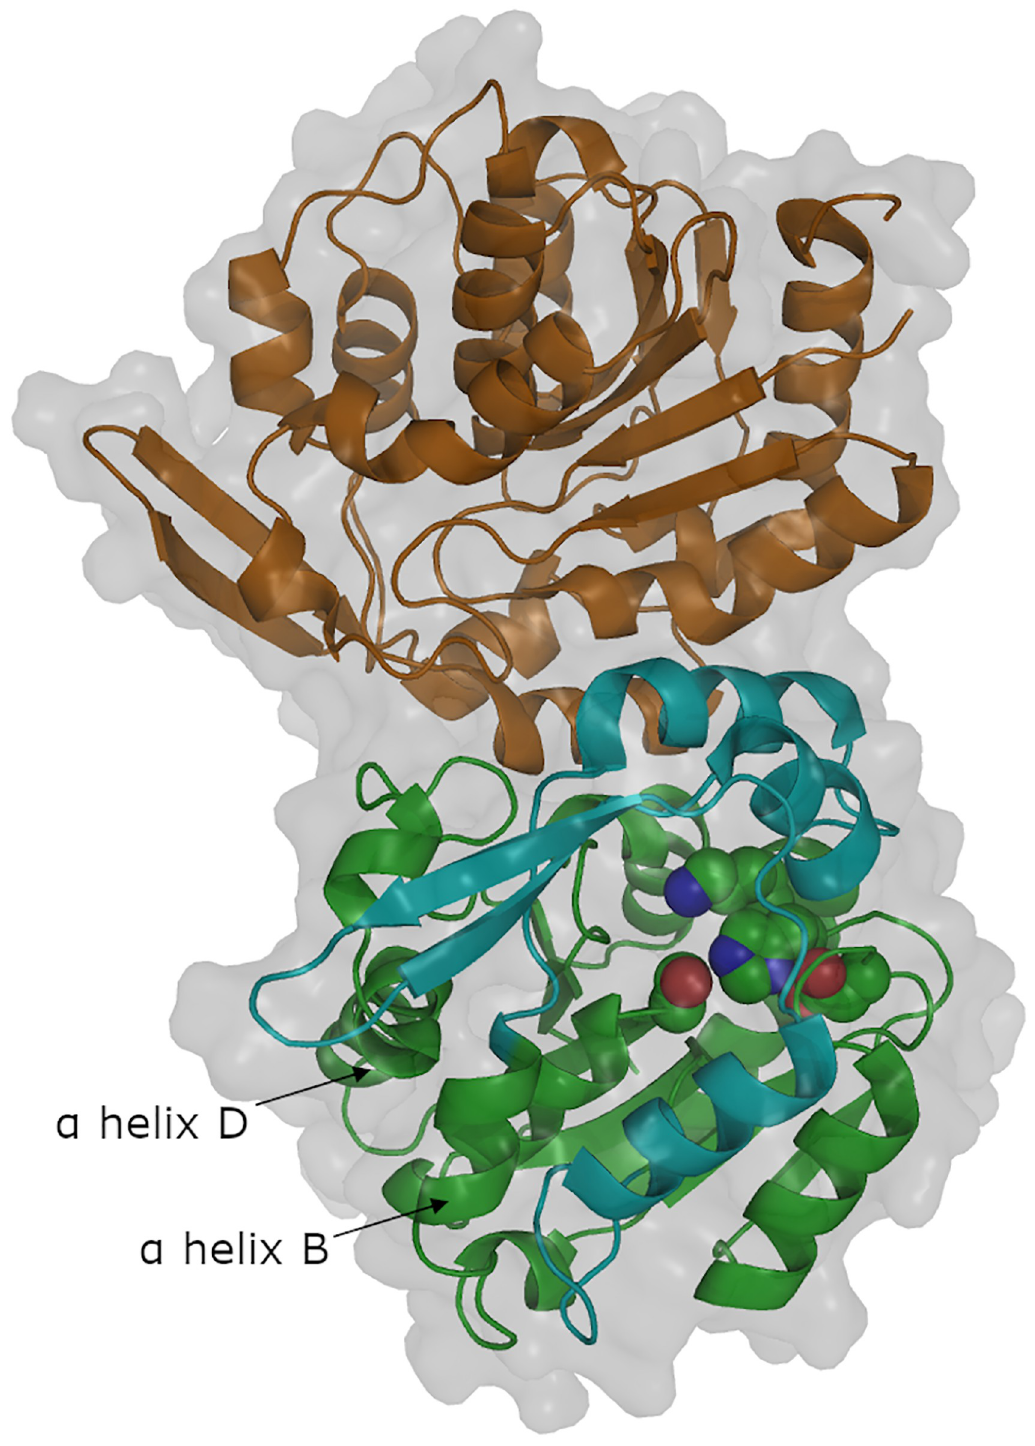
Fig 4. Chains A and B form a dimer in HNL1. The green cartoon indicates the core domain of chain A and the cyan cartoon indicates the cap domain of chain A. The catalytic triad (Ser80-His235-Asp207) and the catalytic lysine 236 are shown as space- filling. The orange cartoon indicates chain B of the dimer. The white surface indicates the solvent accessible surface. The labelled α -helices are discussed later in the paper.